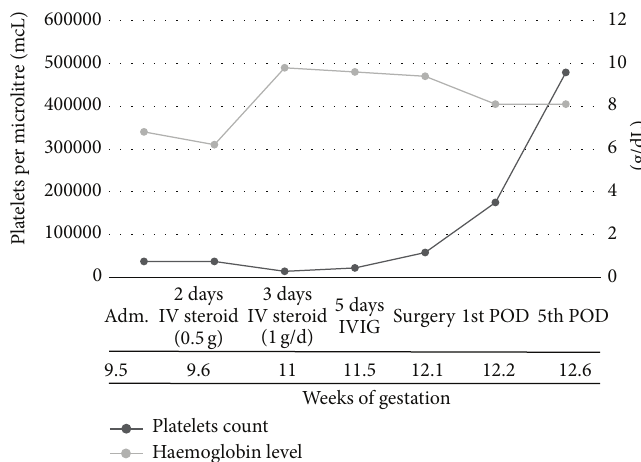
Figure 1: Evolution of platelets count and haemoglobin levels during pregnancy on different treatments. Adm.: admission; IV: intravenous; IVIG: intravenous immunoglobulins; POD: postoperative day.